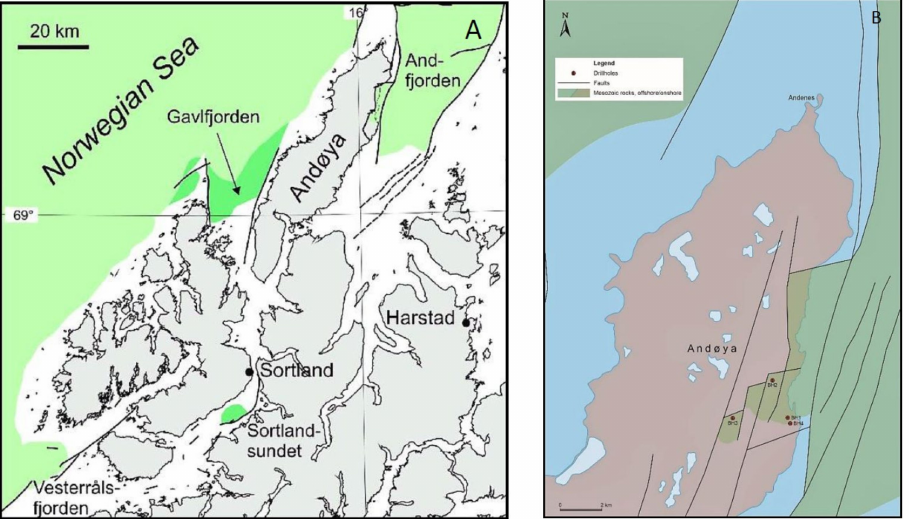
Figure 1. ( A ) Map of Andøya in Northern Norway and outline of the Ramså Basin. ( B ) Locations of boreholes Bh 1, Bh 2, Bh 3 and Bh 4 in the Ramså Basin. Legend: Greenish colour—Onshore Mesozoic rocks on Andøya; Green colour—Offshore Mesozoic rocks; Straight